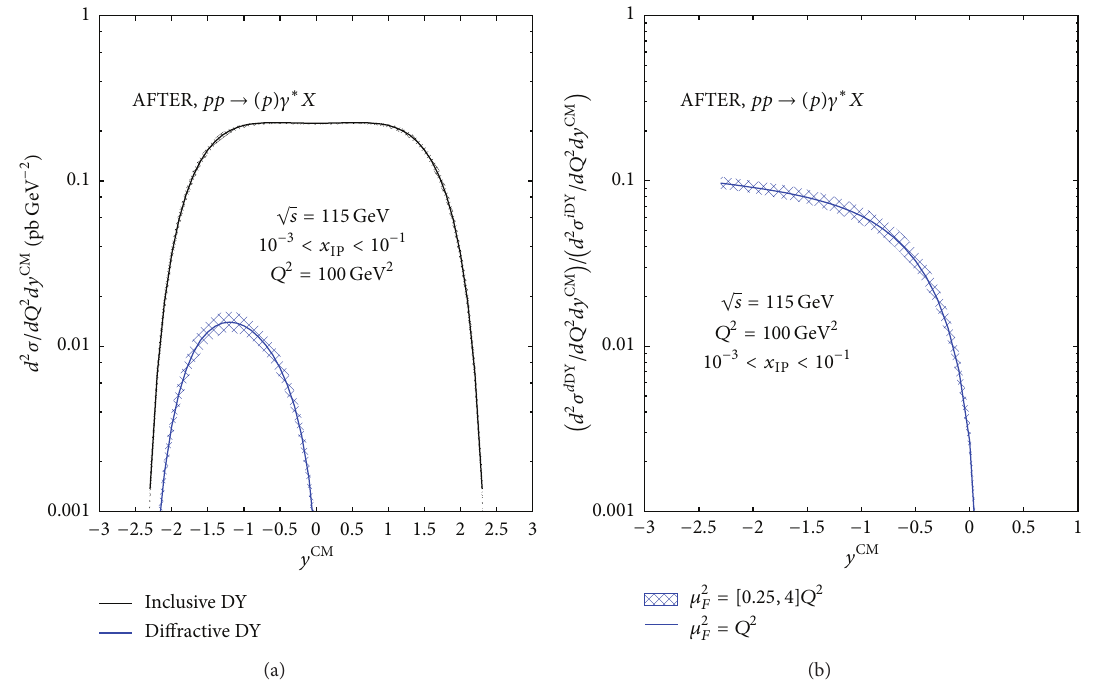
Figure 7: (a) Rapidity distributions for inclusive and diffractive Drell-Yan of mass 𝑄 2 = 100 GeV 2 . Blue error bands represent theoretical errors estimation, as described in the text. (b) Diffractive to inclusive Drell-Yan rapidity distributions